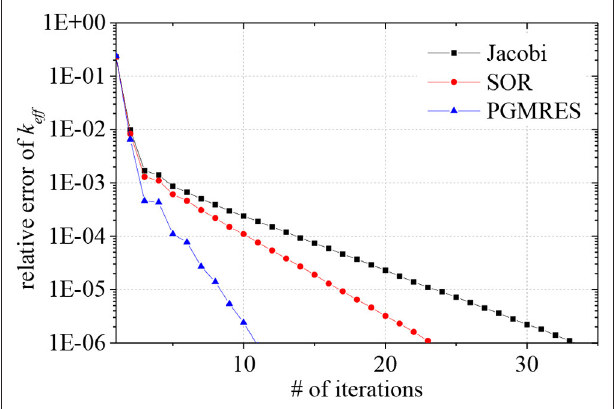
FIGURE 5 | Convergence history of k eff of the different linear system solvers for the mock quarter-core